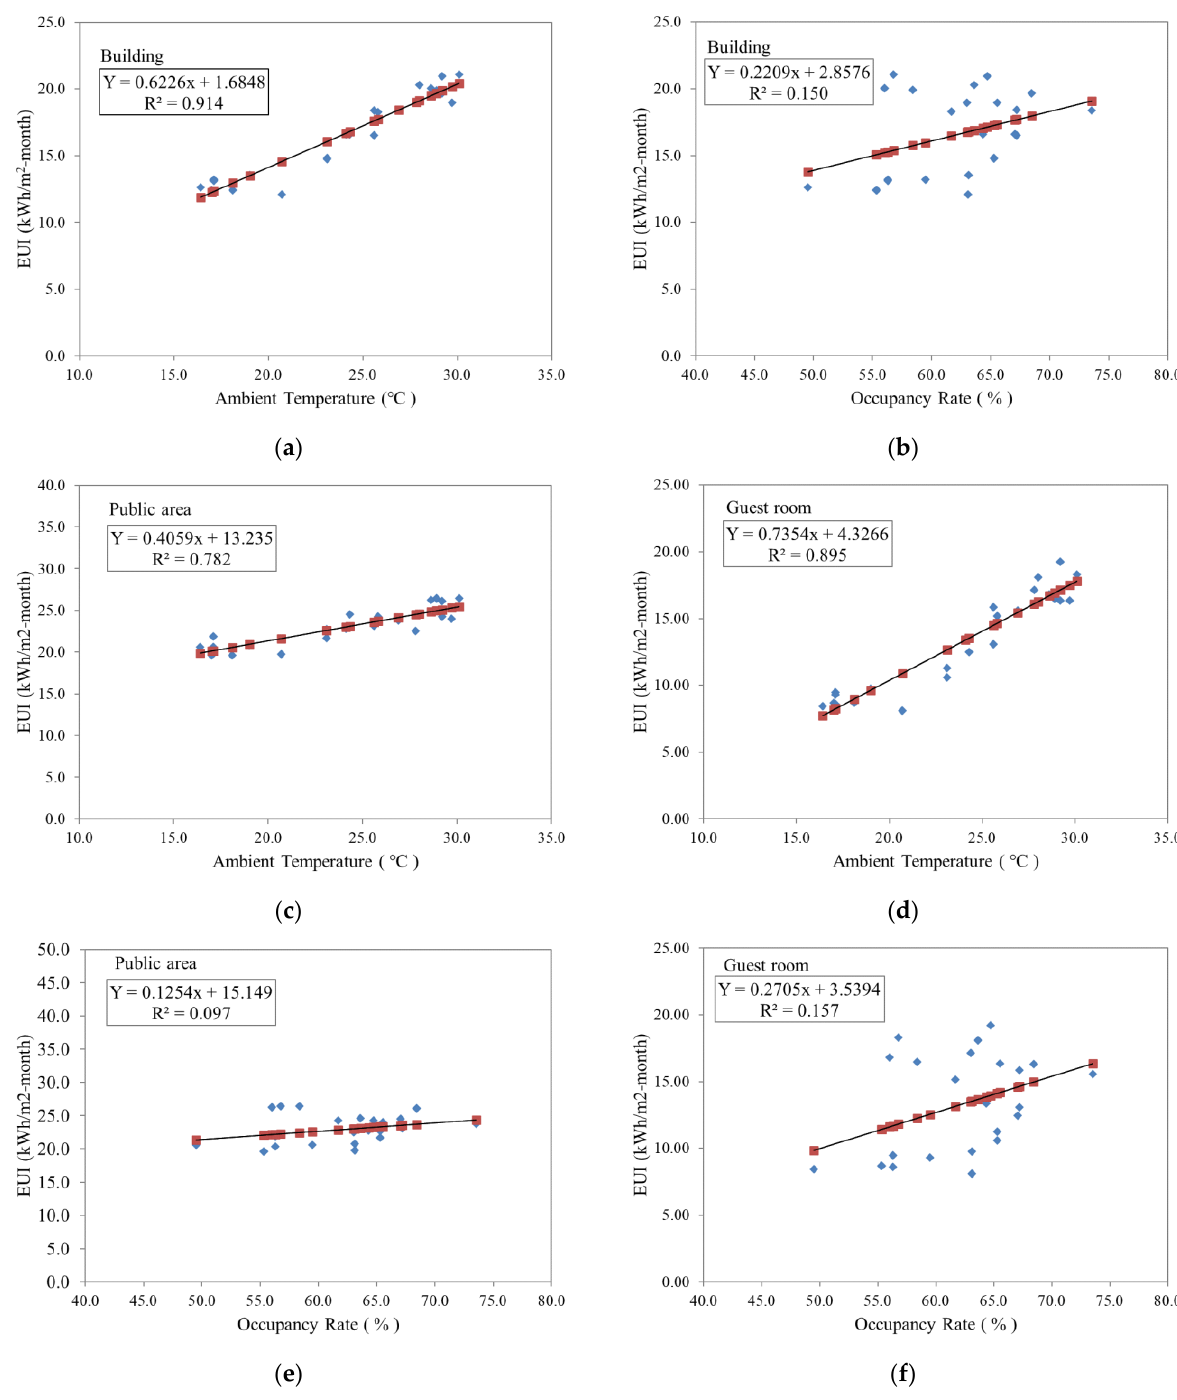
Figure 6. Regression analysis in different conditions. ( a ) EUI total to T A . ( b ) EUI total to O R . ( c ) EUI Public to T A . ( d ) EUI Guest Room to T A . ( e ) EUI Public to O R . ( f ) EUI Guest Room to O R .